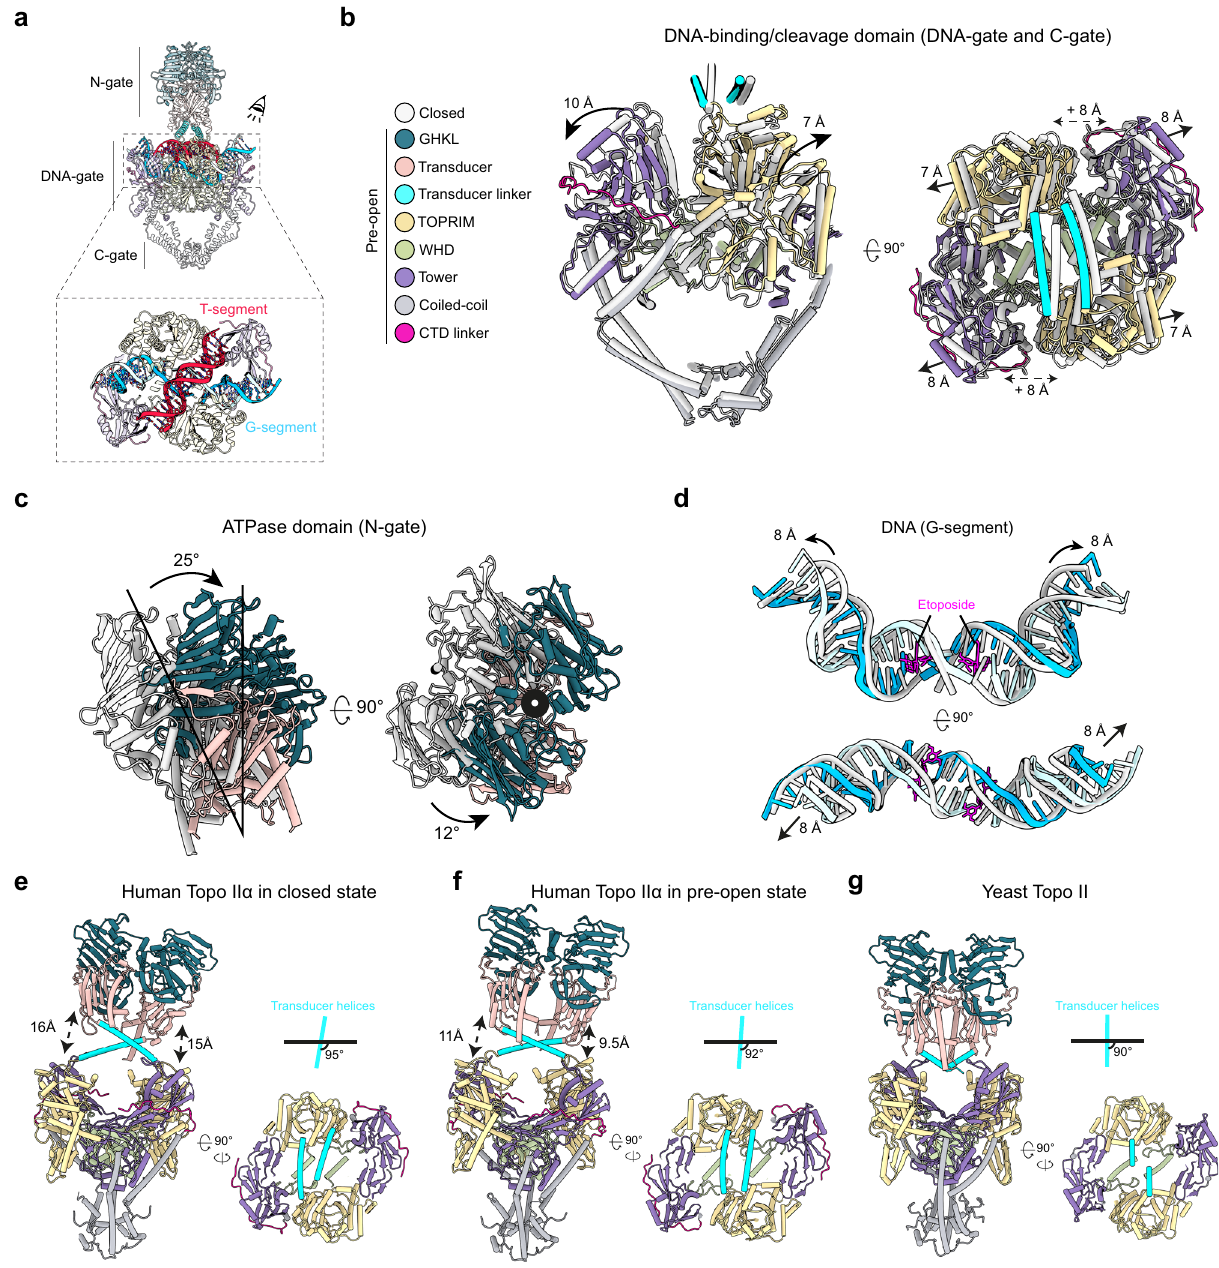
Fig. 3 Structural changes associated with G-segment opening and allosteric connections between the N- and DNA-gates. a Schematic of the different modules of hTopo II α and DNA segments. The T-segment in red is modeled. b Superimposition of DNA-binding/cleavage domain structures in State 1 (closed) (gray) and State 2 (pre-open) (colored based on the legend). TOPRIM domain and Tower domain are moving away from 8 Å in the pre-open state. c A 25° lateral movement of the ATPase domain together with a 12° rotating movement of the ATPase domain (opposite to the intertwining) is observed during the transition from closed to pre-open conformation of the DNA-gate. d During the transition, the DNA is unwound and stretched by 8 Å. e hTopo II α with DNA-gate in closed state: the ATPase domain is bent by ~5° with respect to the vertical axis and also by ~25° in the orthogonal plane, positioning the ATPase domain at a distance of ~15 Å of the DNA-gate (left). The ATPase domain transducer alpha-helices in cyan form a ~95° angle with the DNA-gate (right). f hTopo II α with DNA-gate in pre-open state: the ATPase domain is bent by ~8° with respect to the vertical axis and also by ~5° in the orthogonal plan, positioning the ATPase domain at a distance of ~10 Å of the DNA-gate (left). The ATPase domain transducer alpha-helices in cyan form a ~92° with the DNA-gate (right). g Yeast Topo II with DNA-gate in closed state 12 : the ATPase domain is straight in both orthogonal plans, positioning the ATPase domain in close contact with the DNA-gate (left). The ATPase domain transducer alpha-helices in red form a ~90° with the DNA- gate